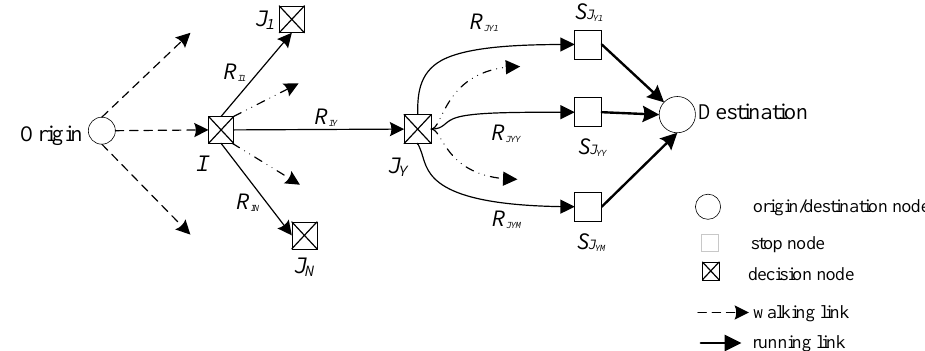
Figure 7. Example of typical graph for transition probability calculation.